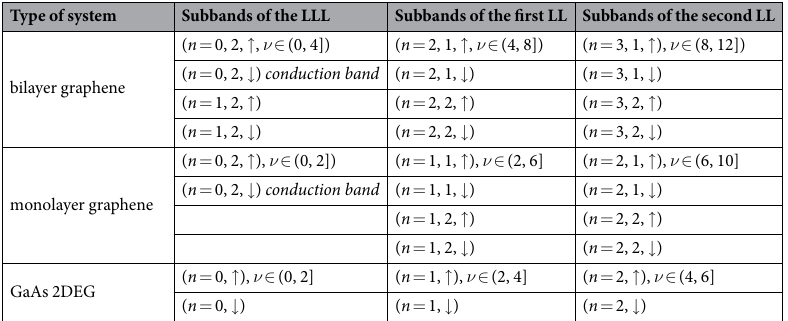
which enhances R xx at ν = + 4(5, 6, 7) 2 . The similar effect of reducing the relative strength of the FQHE fea- 3 tures can be associated with the lowering of the fraction of electrons per subband with rising subband number. The gradual lowering of full octets in the first and the second subbands for n = 2 and the disappearance of a half-octet of FQHE features in the third subband, together with no features being registered in the fourth subband with n = 2 (at least in the temperature range of the experiment, down to 0.5 K) 5 , are consistent with this explana- tion (the smaller fraction of correlated electrons results in lower energy gain, which can be insufficient to over- come the disorder). are too short for single-loop commensurability, whereas orbits hc The orbits reduced due to flux leakage to hc e 1 3 4 give ν = + x 1 and ν = + ( ) x , 1 , respectively, x = 4, 5, 6, 7. Some traces of these features are notice- and hc 2 4 2 4 e able in the experiment, as marked in Fig. 5, which is also consistent with the braid commensurability approach. Specific to bilayer graphene FQHE hierarchy change caused by the type of the LLL 2xSU(4) degeneracy lifting. Bilayer graphene has a different subband structure than monolayer graphene and con- ventional semiconductor 2DEG, as illustrated in Table 1. In bilayer graphene, the extra degeneracy of the n = 0 and n = 1 states results in 8-fold degeneration of the LLL, which is twice the 4-fold spin-valley degeneracy of the LLL in the monolayer case 3 . The Coulomb interaction causes mixing of the n = 0 and n = 1 states via various schemes induced by stress, deformation, structural imper- fections and magnetic field enhancement (as demonstrated in ref. 26 by exact diagonalization in small models), which lifts their degeneracy in the LLL in bilayer. After the degeneracy lifting, the order of the subbands with n = 0 and n = 1 occurs to be of particular importance. The sequences n = 0, 1 and n = 1, 0 lead to different FQHE hierarchies. The FQHE hierarchy for the sequence n = 0, 1 is described in paragraph 1.2. However, in the opposite